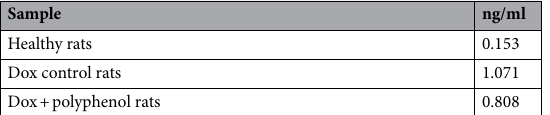
Table 3. Troponin T (TnT). The results of TnT levels from rat serum. The results are average of 3 independent experiments from 6 different